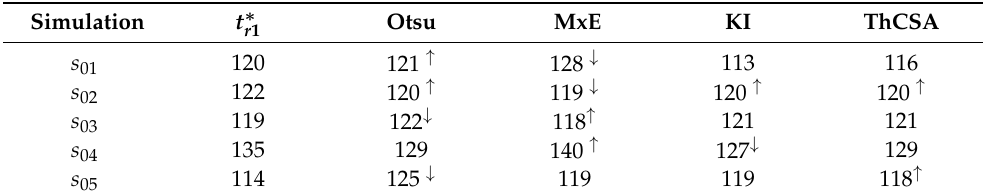
Table 2. Comparison of threshold values obtained by different methods in a simulated environ- ment. Based on the optimal threshold t ∗ , the symbols ↓ and ↑ indicate the worst and the best r 1 threshold